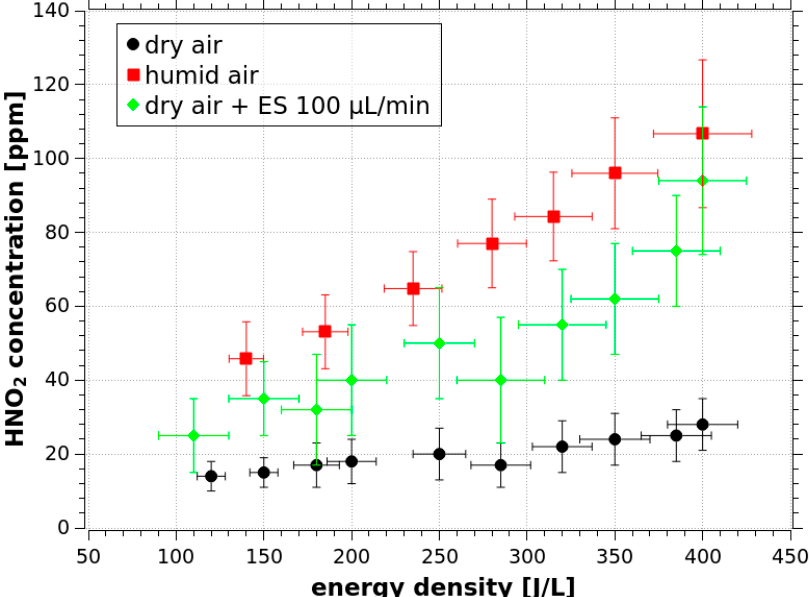
Figure 9. HNO 2 concentration as function of the TS input energy density, measured by UV-Vis absorption technique, short cell, 1SS.